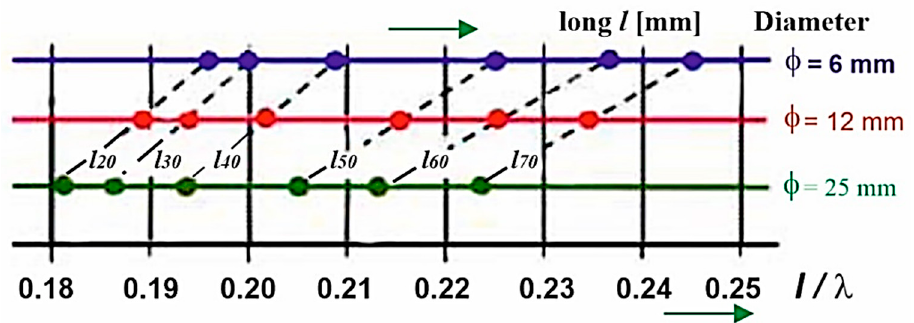
Figure 10. Concentrated distribution of the position of the resonant points of a set of cylindrical antennas.